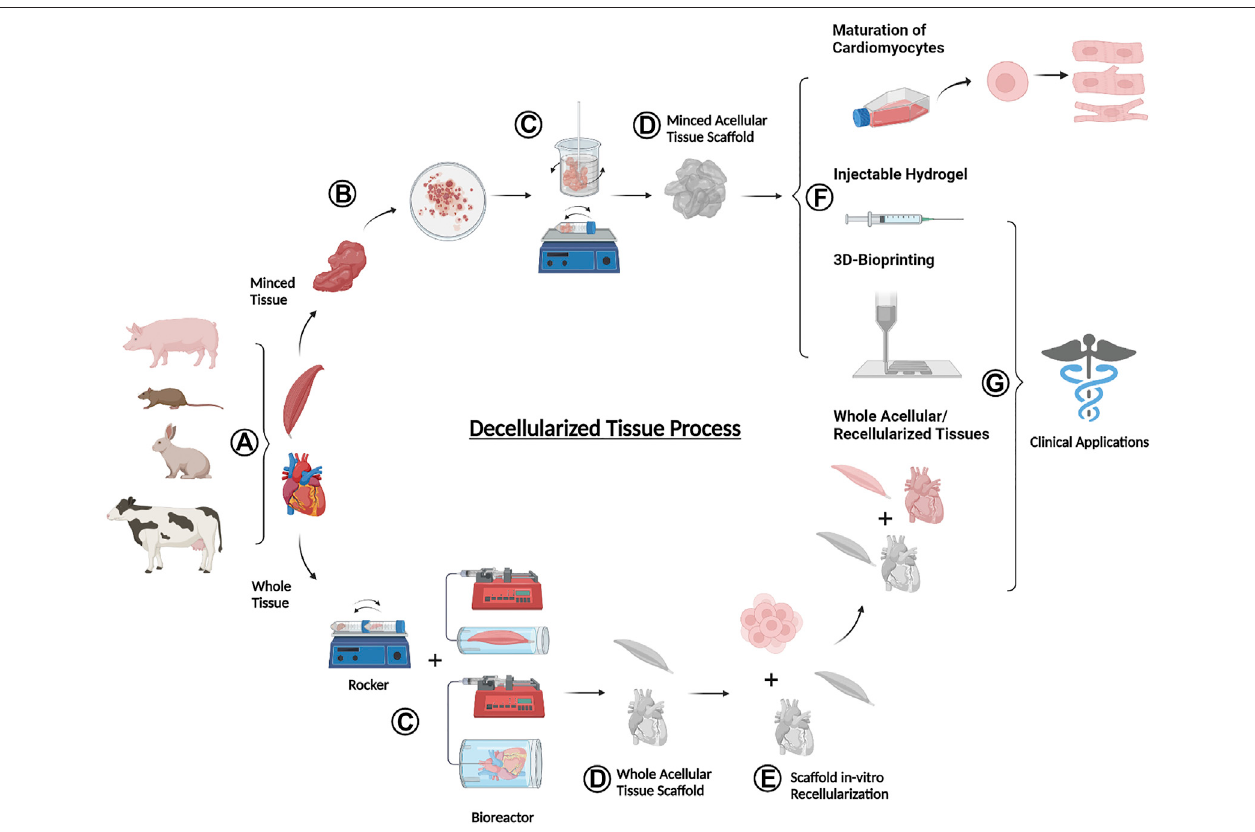
FIGURE1| Schematicoverviewofthedonor-to-applicationlifecycleofdecellularizedtissues (A) Tissuesareharvestedfromananimaldonor (B) Wholetissuesare processed with mechanical agitation to break down into smaller minced tissues (C) Whole or minced fresh tissues are exposed to a series of decellularizing agents and procedures toremove cellular materials (D) Thedecellularization end productsare acellular tissues containingvarious ECM components (E) Whole acellular tissues may beseededwithcells invitro totestforcellviability (F) AvarietyofdECMformsareusedforthematurationofcardiomyocytes,productionofinjectablehydrogels,and formulation into bioink for 3D bioprinting (G) Selected forms of decellularized tissues including injectable hydrogels, 3D bioprinted materials, and whole acellular and recellularized tissues can be used for translational pre-clinical and clinical applications. Figure created using BioRender.com.